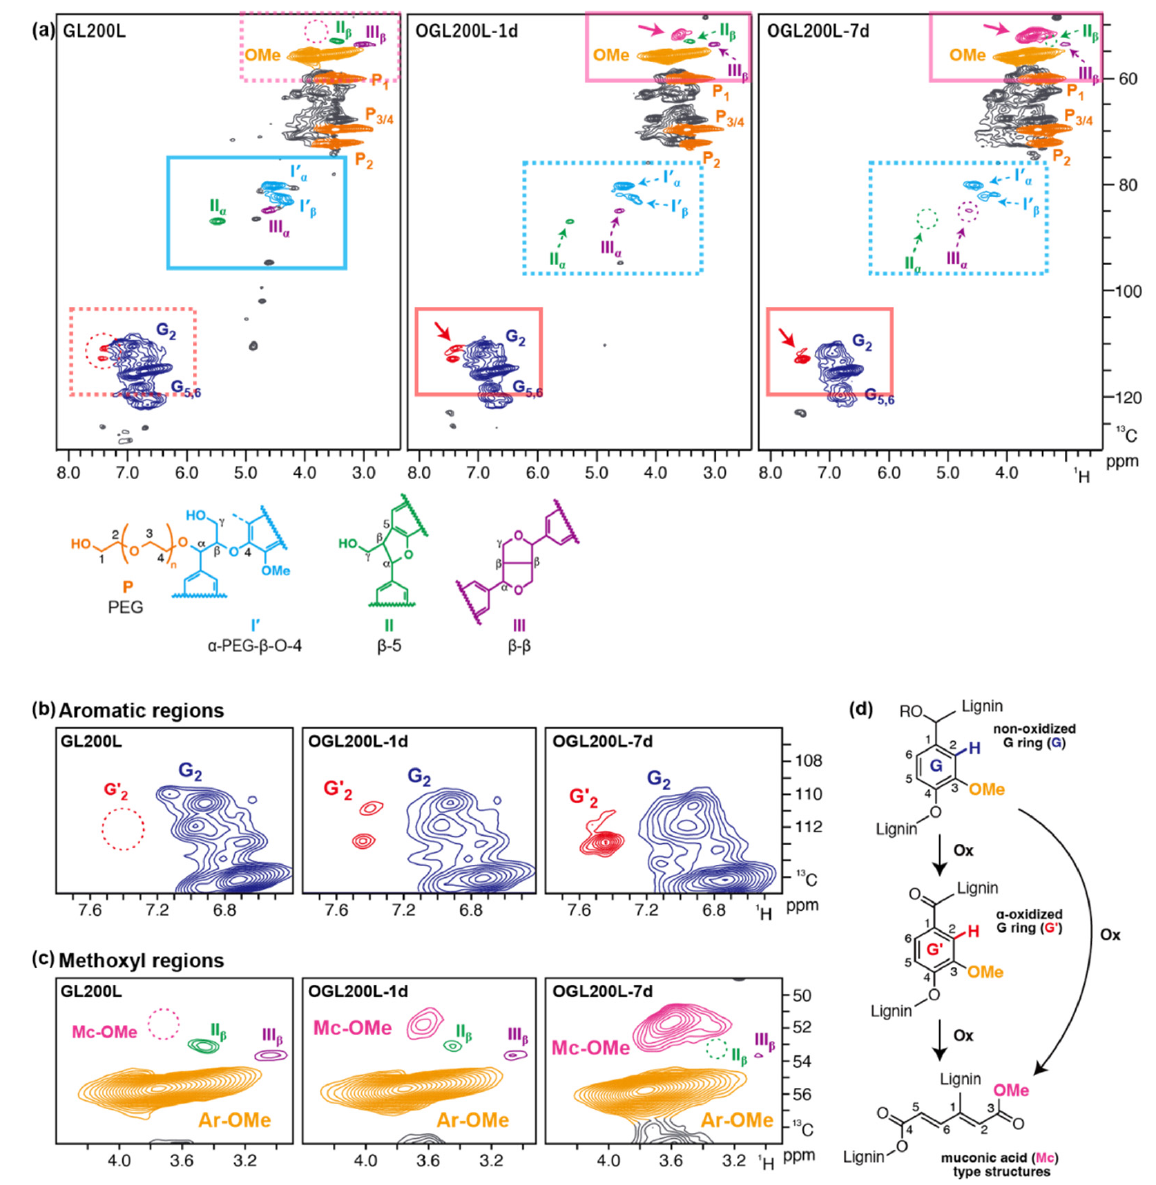
Figure 4. ( a ) 2D HSQC NMR spectra of GL200L and the corresponding OGLs, OGL200L13-1d and OGL200L13-7d. ( b ) Inset of aromatic and ( c ) methoxy regions. ( d ) Ring-opening reaction of guaiacyl aromatic ring into muconic acid (Mc)-type structures. Table 4. Rough estimations of oxidation degree of OGLs based on HSQC NMR contour integra- tion.